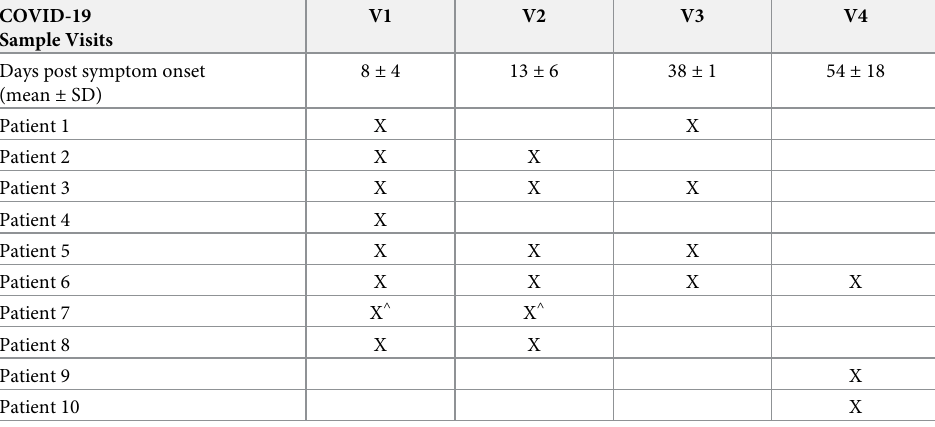
Table 2. COVID-19 patient visit